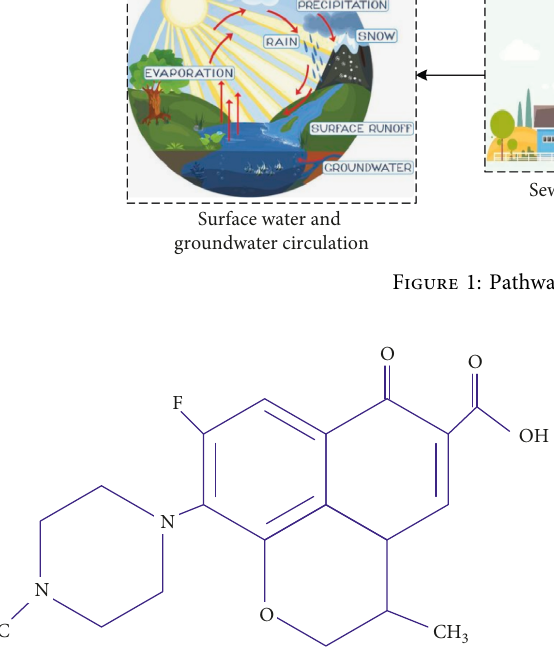
Figure 2: Molecular structure of